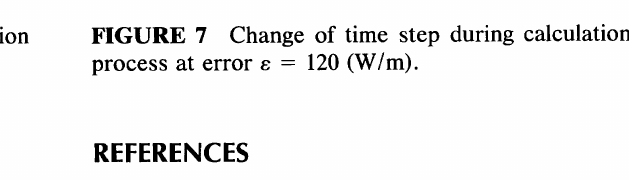
FIGURE 5 Change of time step during calculation process at error e = 60 (W/m).